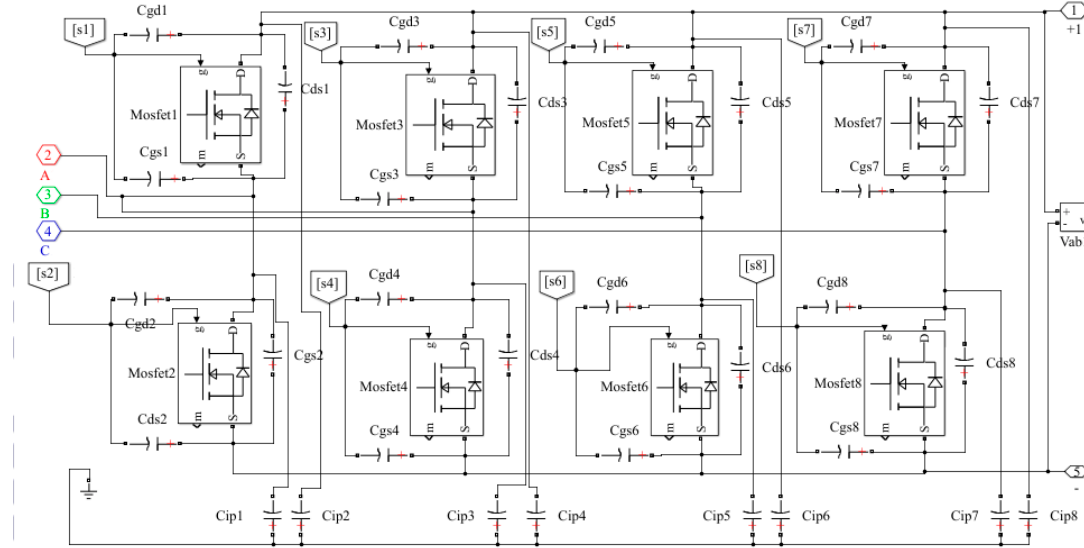
Figure 25. Circuit simulation model of three-phase four-leg rectifier.